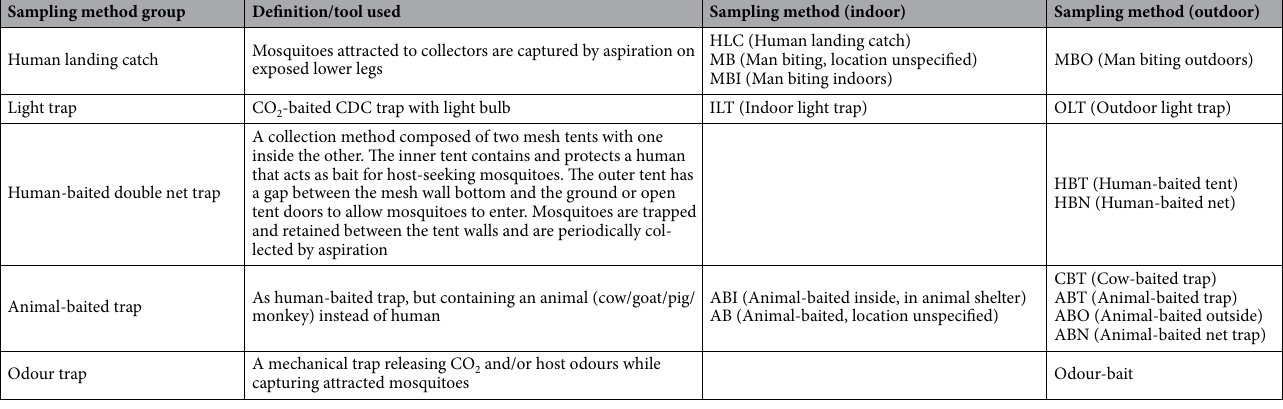
Table 1. Sampling methods for host-seeking mosquitoes. The different sampling methods recorded in Massey et al. (2016) 19 targeting host-seeking mosquitoes were grouped into categories of techniques/tools used as proposed by Farlow et al. (2020) 9 .